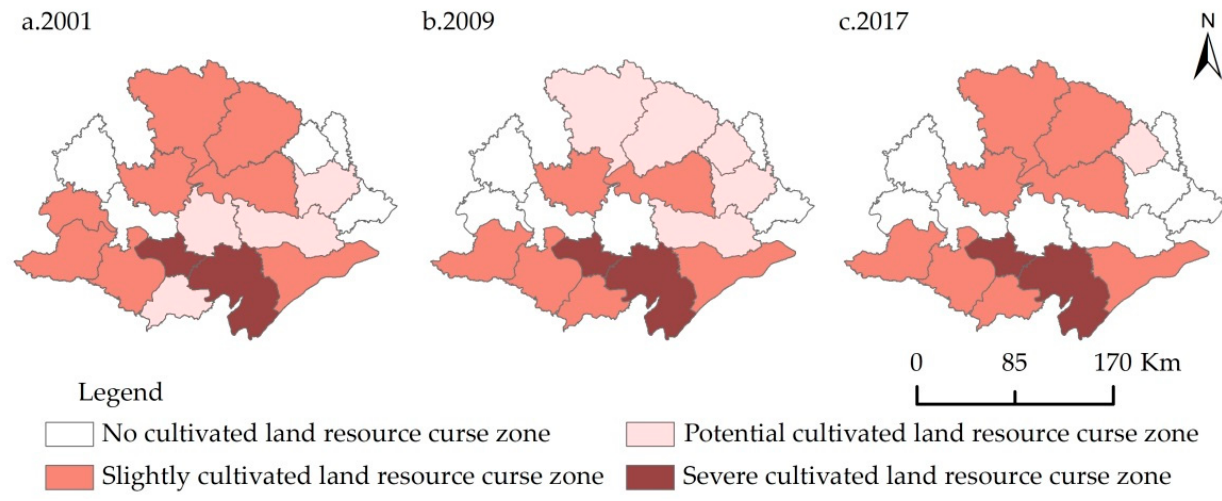
Figure 5. Spatial evolution of the cultivated land resource curse in Jianghan Plain.